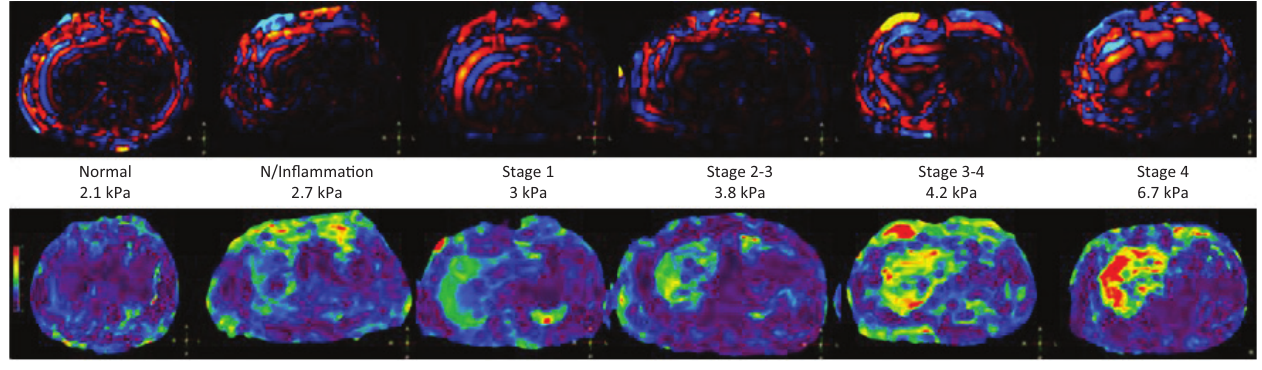
FIG URE 2: Wave and colour images of patients ranging from normal liver stiffness measurement to stage 4 fibrosis.